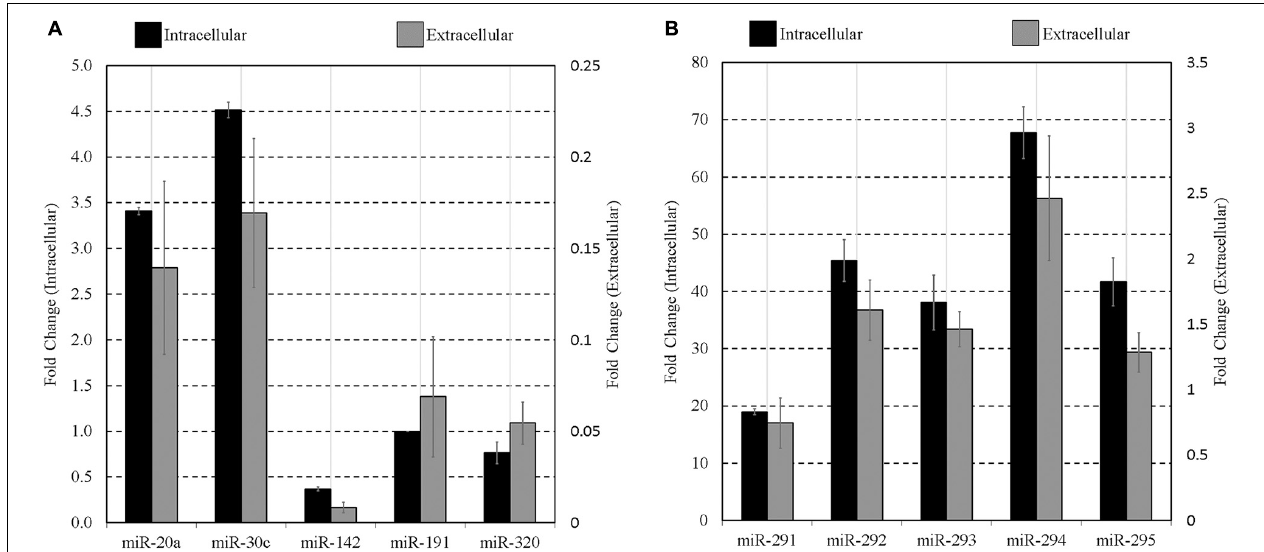
FIGURE 3 | Intracellular vs. extracellular miRNA expression profiles of select miRNA panel sequences in late-stage blastocysts. The late blastocyst (116 h post-hCG) miRNA panels (A,B) expression profiles are compared against that found within the spent media microdroplet after 17 h of culture (99–116 h post-hCG). All expression is normalized to endogenous intracellular miR-191. Culture consisted of 20 morula or early blastocysts per 20 µ L. Each data point represents 1.25 µ L of conditioned culture media. Blank media was cultured in tandem and used as a negative control. n = 3, error bars = SEM.